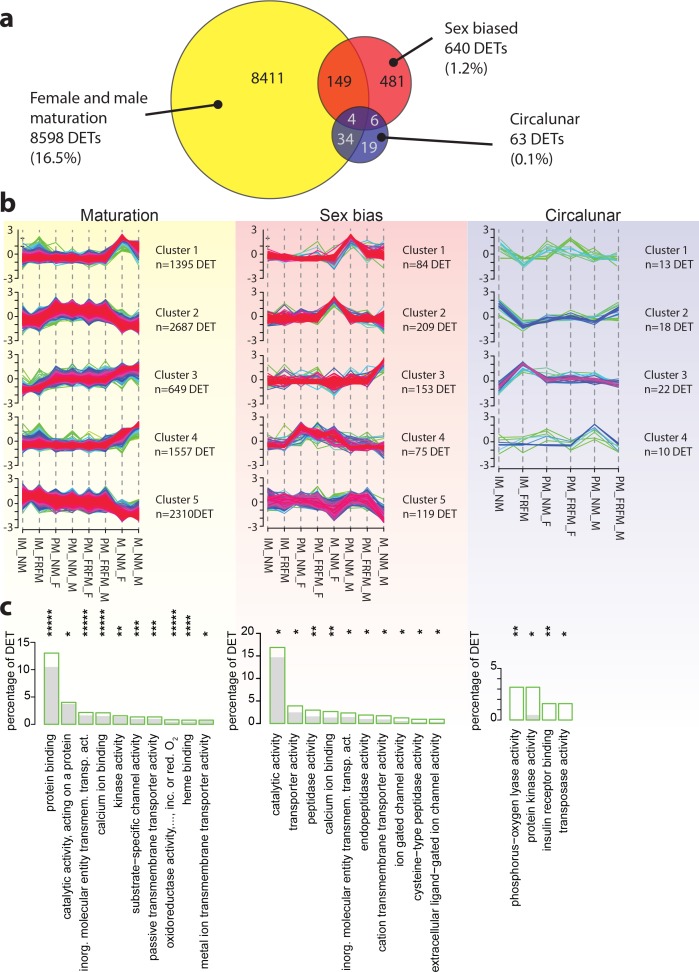
Maturation, sex and circalunar phase have distinct transcriptomic signatures in Platynereis heads.(a) Venn diagram showing the overall numbers of genes identified as significantly regulated within and across the three different biological processes. Percent in brackets indicate the respective fraction compared to total number of analyzed IDs. (b) Soft clustering of differentially expressed genes using the Mfuzz algorithm. Maturation (yellow) and sexual differences (light red) yielded five clusters; circalunar phase-regulated (light blue) expression was best represented by four clusters. Compare to Figure 5b for similarity to regulated protein clusters. (c) Results from the GO-term enrichment analysis using the GOStats package on the differentially expressed genes in each comparison; the ten most abundant terms in the Molecular Function category are displayed (for more GO-results see Figure 3—figure supplement 1–9). Green boxes: actual percentage of differentially expressed transcripts for each term; grey bars: expected number of transcripts per category. Maturation: protein binding: GO:0005515, catalytic activity, acting on a protein: GO:0140096, inorganic molecular entity transmembrane transporter activity: GO:0015318, calcium ion binding: GO:0005509, kinase activity: GO:0016301, substrate-specific channel activity: GO:0022838, passive transmembrane transporter activity: GO:0022803, oxidoreductase activity, acting on paired donors, with incorporation or reduction of molecular oxygen: GO:0016705, heme binding: GO:0020037, metal ion transmembrane transporter activity: GO:0046873. Sex bias: catalytic activity: GO:0003824, transporter activity: GO:0005215, peptidase activity: GO:0008233, calcium ion binding: GO:0005509, inorganic molecular entity transmembrane transporter activity: GO:0015318, endopeptidase activity: GO:0004175, cation transmembrane transporter activity: GO:0008324, ion gated channel activity: GO:0022839, cysteine-type peptidase activity: GO:0008234. Circalunar phase: phosphorus-oxygen lyase activity: GO:0016849, protein kinase activity: GO:0004672, insulin receptor binding: GO:0005158, transposase activity: GO:0004803. Statistical significance was tested with a hypergeometric G-test implemented in the GOStats package. *p < 0.05, **p < 0.01, ***p < 0.001, ****p < 0.0001, *****p < 0.00001.10.7554/eLife.41556.024Figure 3—source data 1.Platynereis head reference transcriptome v5 read counts.Table containing the raw read count data for TS_v5. This table is used as input for differential expression analysis.10.7554/eLife.41556.025Figure 3—source data 2.Transcriptome: DESeq normalised read counts.Normalised read counts of TS_v5 as calculated by the DESeq2 algorithm; used to build DET expression graphs.10.7554/eLife.41556.026Figure 3—source data 3.Platynereis head reference transcriptome v5 gene universe.Table containing the "gene universe" for the TS_v5 used as background for GO-term enrichment analysis in Figs. 3 and S3a-k.10.7554/eLife.41556.027Figure 3—source data 4.Transcriptome: DESeq output tables.File containing DESeq predicted DETs for all 14 comparision made. Each comparison is contained within a separate tab.10.7554/eLife.41556.028Figure 3—source data 5.Transcriptome: EdgeR output tables.File containing EdgeR predicted DETs for all 14 comparision made. Each comparison is contained within a separate tab.10.7554/eLife.41556.029Figure 3—source data 6.Transcriptome: DESeq2-EdgeR rank sum files.This file contains DESeq2-EdgeR rank sums for predicted DETs for all 14 comparision made plus the all maturation rank sum predictions. Each comparison is contained within a separate tab. Note that while DESeq2 calculates the log2 fold change as A/B; EdgeR calculates the log2 fold change as B/A. log2FoldChange: DESeq2; log2FC: EdgeR; padj: BH-adjusted p-value DESeq2; FDR: BH-adjusted p-value EdgeR.10.7554/eLife.41556.030Figure 3—source data 7.Transcriptome: Mfuzz cluster gene IDs with cluster membership values.This file contains the soft clustering output of RNA expression values with Mfuzz. Each comparison, maturation, sex, and lunar contains the individual transcript ID and the membership values for each cluster ranging from 0 to 1.10.7554/eLife.41556.031Figure 3—source data 8.Transcriptome: all over- and under-represented GO-Terms from all comparisions.Table containing the results of the GO-term analysis on transcript level. Individual GO-terms are shown with their respective p-values in each of the three comparisons made (maturation, sex, and lunar), as well as their ontolgy, i.e. Molecular Function, Biological Process, or Cellular Compartment.10.7554/eLife.41556.032Figure 3—source data 9.Transcriptome: over- and under-represented GO-Terms maturation comparison.This file contains the over- and under-representet GO-terms for the maturation comparison on transcript level. Tabs for each of the three ontologies, i.e. Molecular Function, Biological Process, and Cellular Compartment.10.7554/eLife.41556.033Figure 3—source data 10.Transcriptome: over- and under-represented GO-Terms sex bias comparison.This file contains the over- and under-representet GO-terms for the sex comparison on transcript level. Tabs for each of the three ontologies, i.e. Molecular Function, Biological Process, and Cellular Compartment.10.7554/eLife.41556.034Figure 3—source data 11.Transcriptome: over- and under-represented GO-Terms circalunar comparison.This file contains the over- and under-representet GO-terms for the lunar comparison on transcript level. Tabs for each of the three ontologies, i.e. Molecular Function, Biological Process, and Cellular Compartment.10.7554/eLife.41556.035Figure 3—source data 12.Transcriptome: over-represented GO-Term unique for any of the three comparisons.This file contains those over-represented GO-terms which are unique to a given comparison on transcript level, i.e. maturation, sex, or lunar, with p-values for each of the three comparision.10.7554/eLife.41556.036Figure 3—source data 13.All transcripts significantly regulated during maturation (maturation DETs).This file contains the IDs, mean expression values, top hit by blastX with e-value cut-off 10-4, e-value corresponding to blast hit, number of identical/ similar AA or gaps in blast alignment ("identity", "positives", "gaps") for all transcripts significantly regulated during maturation.10.7554/eLife.41556.037Figure 3—source data 14.All transcripts significantly regulated during sexual differentiation (sex DETs).This file contains the IDs, mean expression values, top hit by blastX with e-value cut-off 10-4, e-value corresponding to blast hit, number of identical/ similar AA or gaps in blast alignment ("identity", "positives", "gaps") for all transcripts significantly regulated between males and females.10.7554/eLife.41556.038Figure 3—source data 15.All transcripts significantly regulated between circalunar phases (lunar DETs).This file contains the IDs, mean expression values, top hit by blastX with e-value cut-off 10-4, e-value corresponding to blast hit, number of identical/ similar AA or gaps in blast alignment ("identity", "positives", "gaps") for all transcripts significantly regulated between circalunar phases.